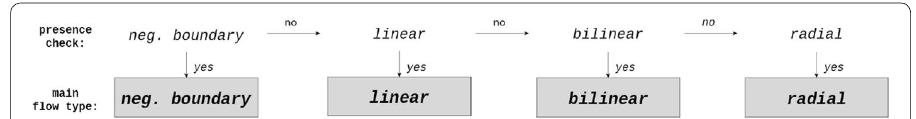
Fig. 6 Decision tree for the classification of DER curve based on the detection of a flow type in any of the curves data